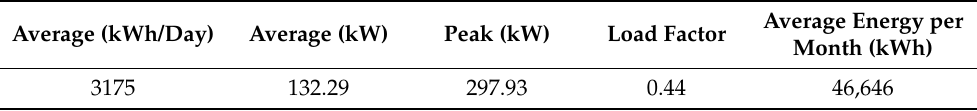
Figure 4. Daily ( top ), seasonal ( middle ) and annual ( bottom ) load profiles for Yas Island. Table 2. Technical information regarding the load profile. Table 2. Technical information regarding the load